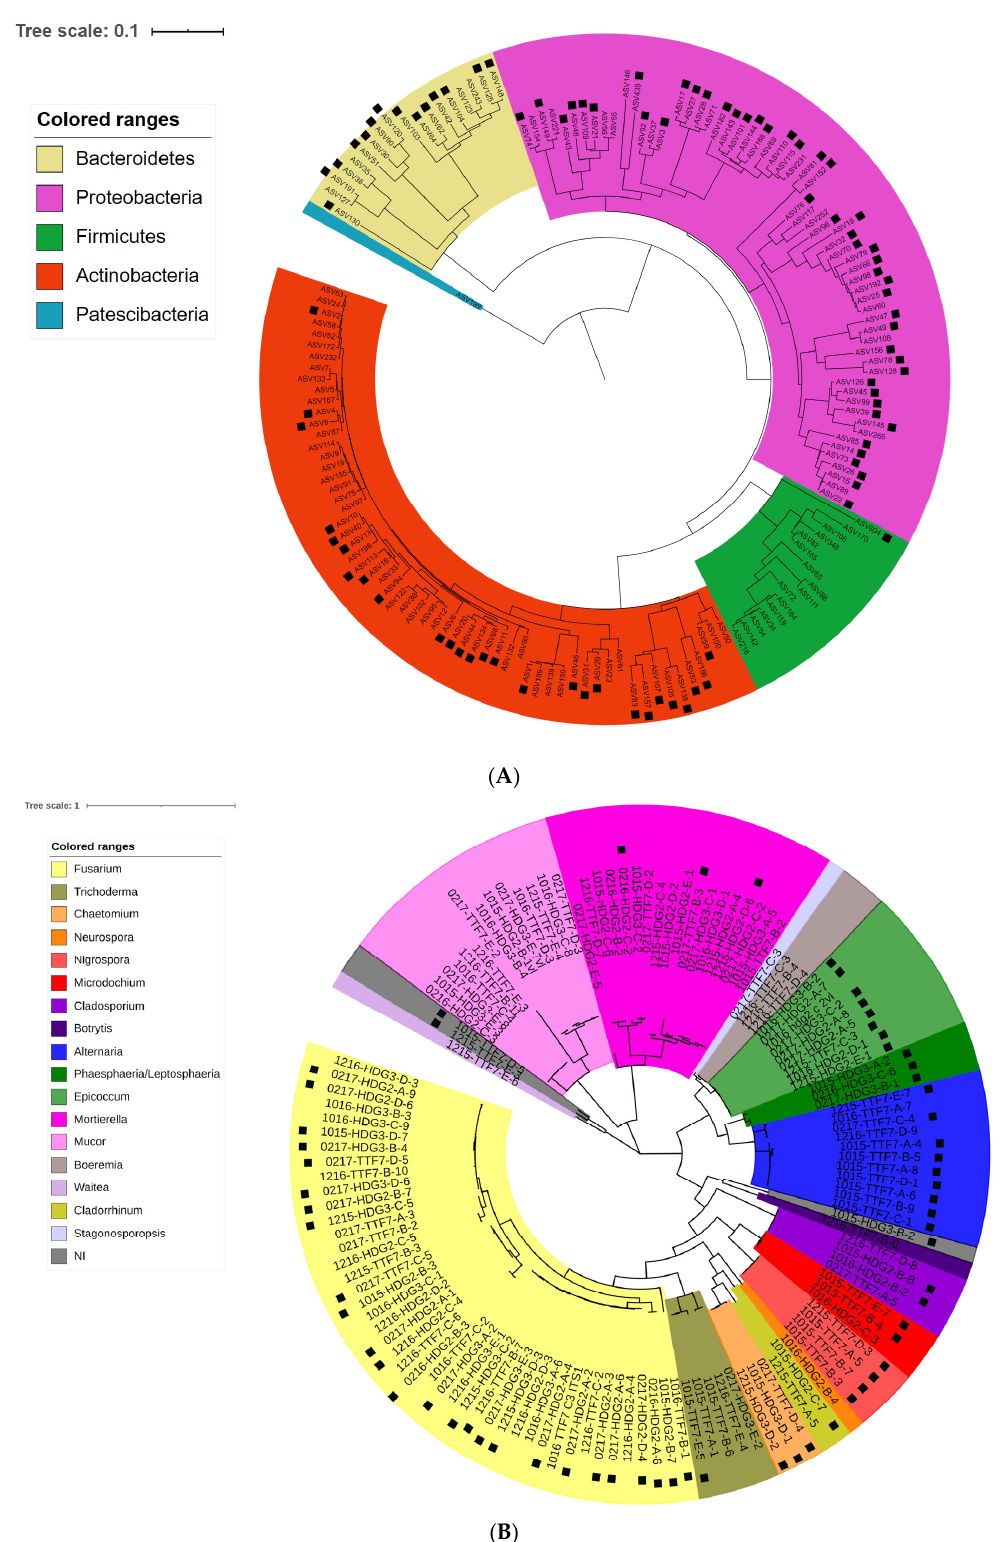
Figure 3. Phylogenetic distribution of the bacterial strains (from 15 residue samples) and fungal strains (from 1080 residue samples) recovered through culture collection. A neighbor-joining phylogenetic tree was constructed ( A ) with the v4 region of 16S rRNA gene of all unique bacterial ASVs ( n = 158) and ( B ) the ITS1-5.8S-ITS2 region of all unique fungal ASVs ( n = 131) detected in each culture collection. The presence of an ASV from isolated strain displaying 100% identity to the corresponding region in the metabarcoding dataset [5] is indicated by a black